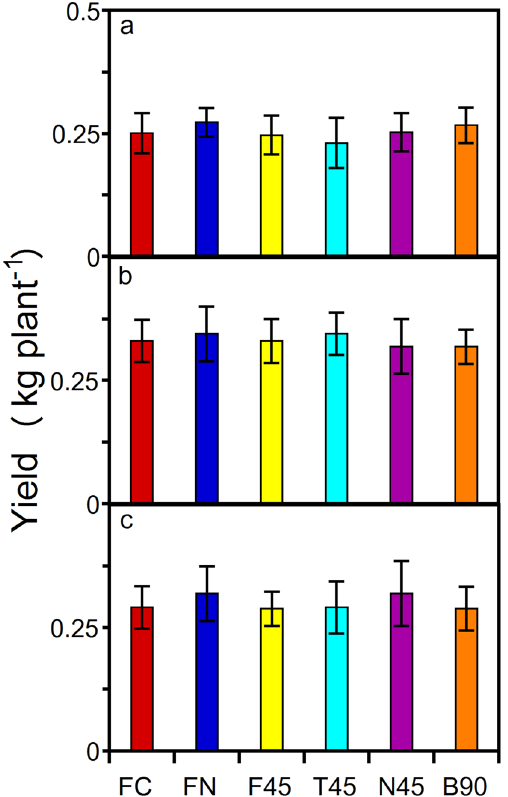
Figure 5. The hop mean dry cone yield (node 20–40; kg) across treatments for ( a ), cultivar ‘Cascade’. ( b ), cultivar ‘Cashmere’, and ( c ), cultivar ‘Centennial’. Control free to climb at 90° (FC), free to climb a strand of 90° netting (FN), free to climb twine at 45° (F45), touch on twine at 45° (T45), touch on a single strand of trellis netting at 45° slope (N45), and 90° internode bending on netting at a 45° mean slope (B90). Means and standard deviation of six replicates (n = 6). Yield means were not statistically different from each other ( P >